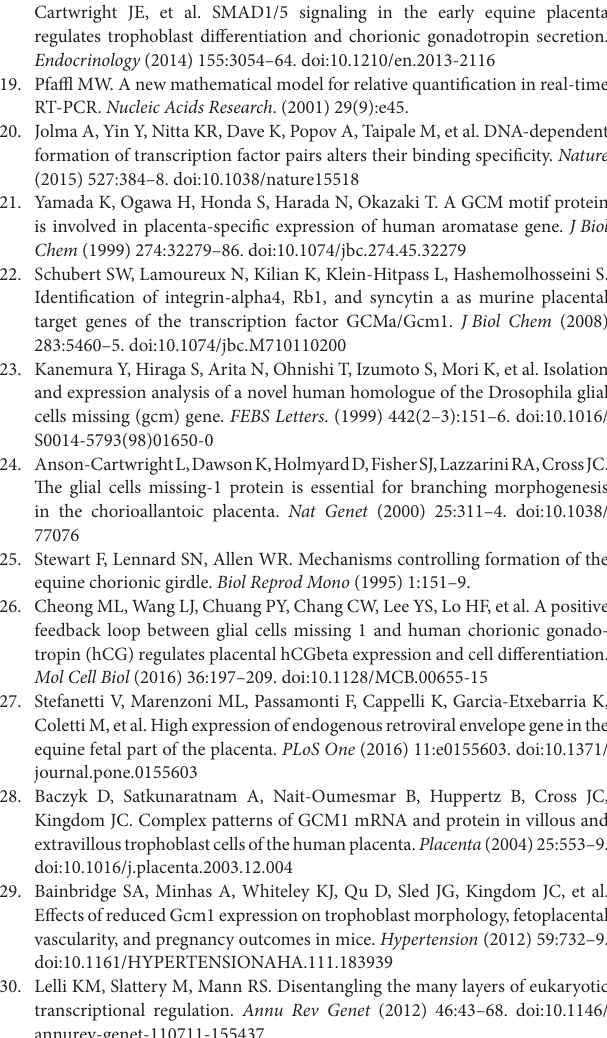
and primers designed to detect sites, 1–4 and two control sites that were not predicted GCM1 binding sites within 500 bp ( n = 2 conceptuses). Only sites 1–3 and one control site were taken forward to quantitative RT-PCR shown in Figure 3a